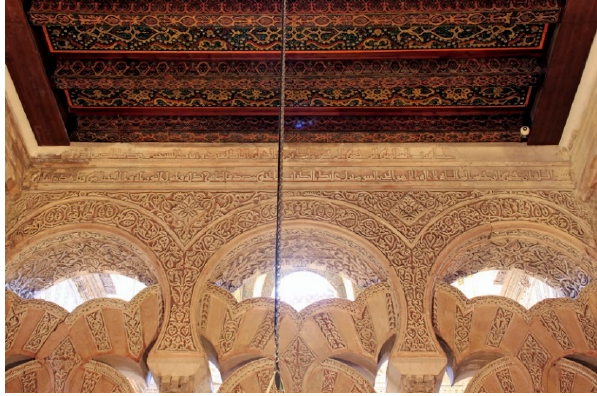
Figure 14. Great Mosque of Cordoba. Screen of intersecting arches delimiting the central bay of the maq ṣ ū ra . © Photo took by